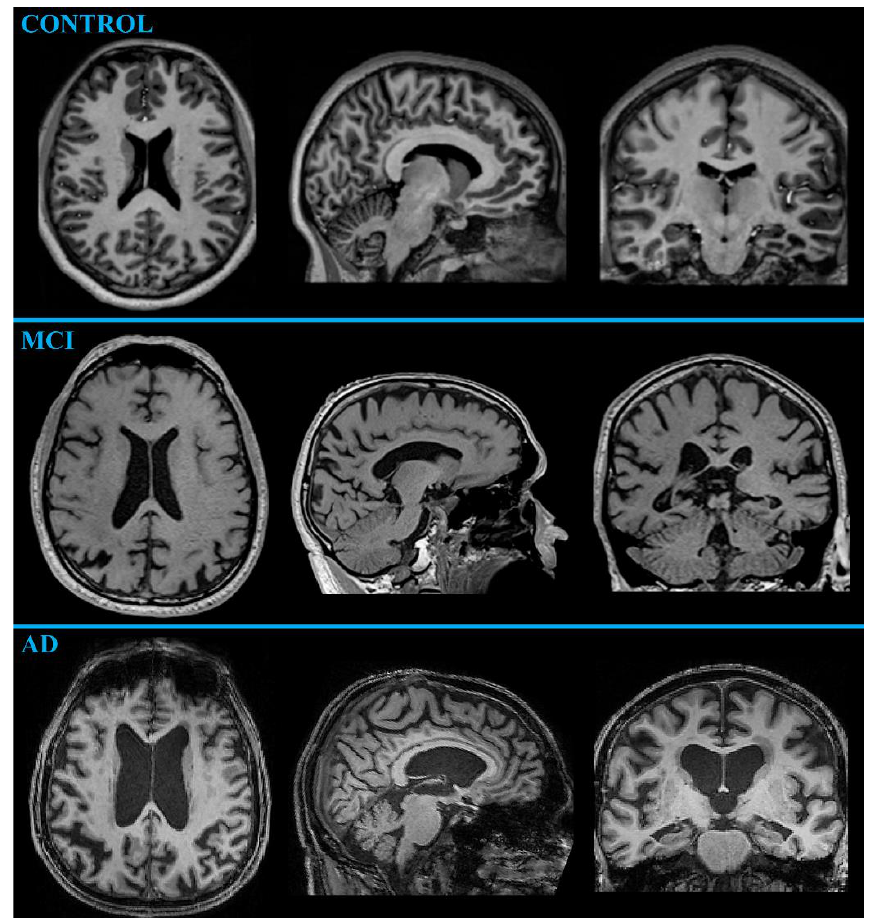
Figure 1. Example of MR neuroimaging (T 1 -weighted MRI at 3 Tesla MR-scanner) of a control subject (70-year-old female), of an MCI patient proceeding to AD in two years (72-year-old male), and of an AD patient (75-year-old female) in axial, sagittal, and coronal sections. The differences are visually subtle, but the increased atrophy in the medial temporal lobe and the enlarged ventricles are apparent in MRI.